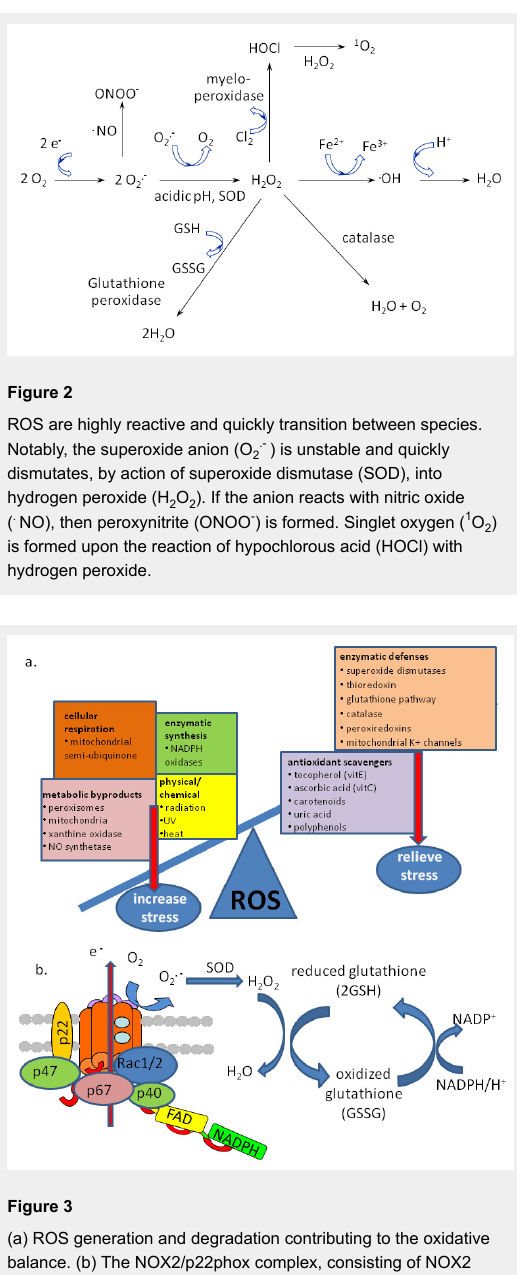
(a) ROS generation and degradation contributing to the oxidative balance. (b) The NOX2/p22phox complex, consisting of NOX2 (orange) and the subunits p47, p67, and p40 (left) and glutathione defense mechanism (right). The superoxide (O 2.– ) generated by the NOX complex is rapidly dismutated by superoxide dismutatase (SOD), where it can enter the glutathione synthesis and recuperation